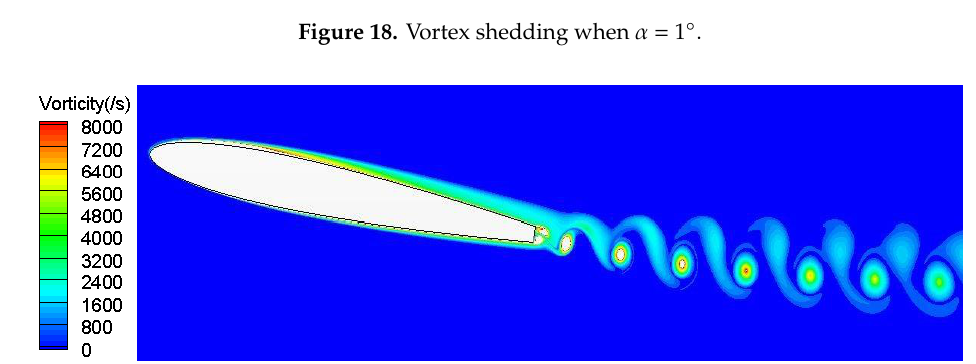
Figure 19. Vortex shedding when α = 9°.